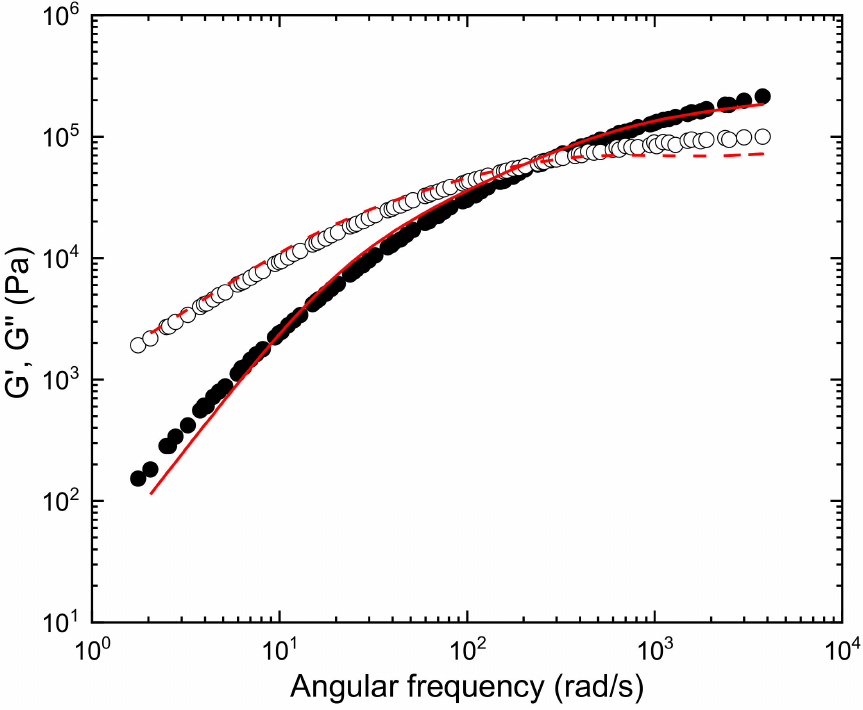
Figure 6. Master curve at the reference temperature T = 190 ◦ C for PHBH fitted to the Likhtman–McLeish = 400,000 Pa, M e = 8960 g/mol and τ e = 3.5 × 10 − 6 s, τ theory. [ G 0 N